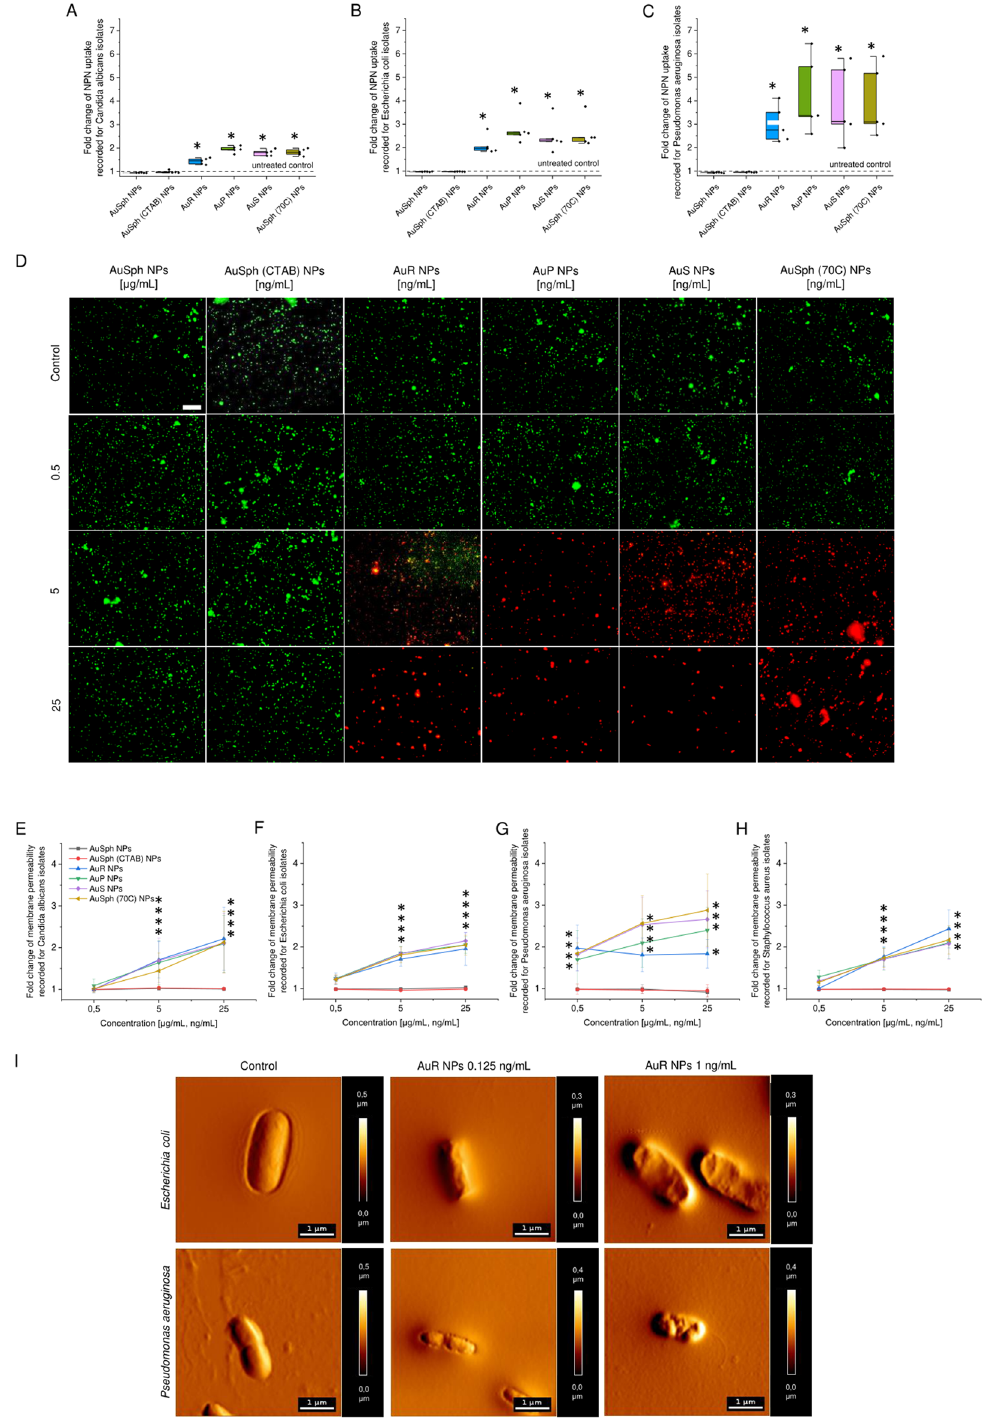
Figure 3. Increase of microbial membrane permeability upon treatment with varied-shaped gold nanoparticles. Uptake of NPN into C. albicans, E. coli and P. aeruginosa cells induced by treatment with spherical- and non-spherical gold nanoparticles ( A – C ). Decrease of viability of S. aureus bacteria followed incubation with developed nanoparticles evaluated using fluorescence microscopy ( D ). Scale bar ~ 100 µm. Au NPs-mediated increase of cellular membranes permeability of C. albicans ( E ), E. coli ( F ), P. aeruginosa ( G ) and S. aureus cells ( H ). AuR NPs-induced damage of membrane of representative isolates of E. coli and P. aeruginosa investigated using AFM ( I ). Results are presented as mean ± SD from 5 representative strains ( A – C , E – H ). For panels ( D ) and ( I ), the results from one representative experiment are shown. *Indicates statistical significance ( p < 0.05) when compared to untreated